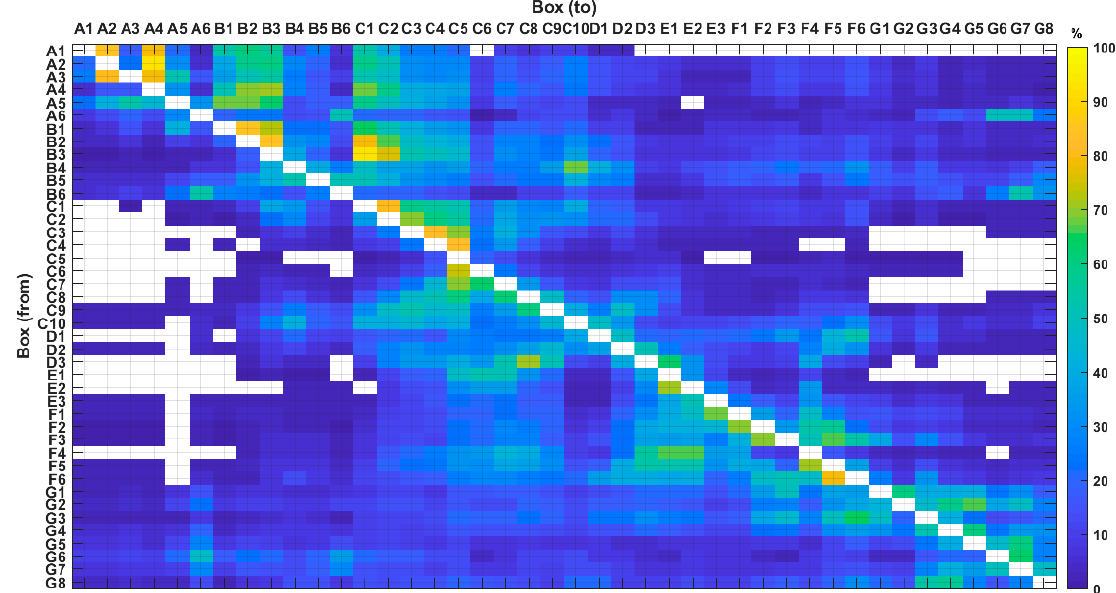
Figure 7. Percentage of drifters connecting the 42 boxes of the WMED. Each area extends over a 1° × 1° cell. Drifter data refer to the 1985–2016 period.